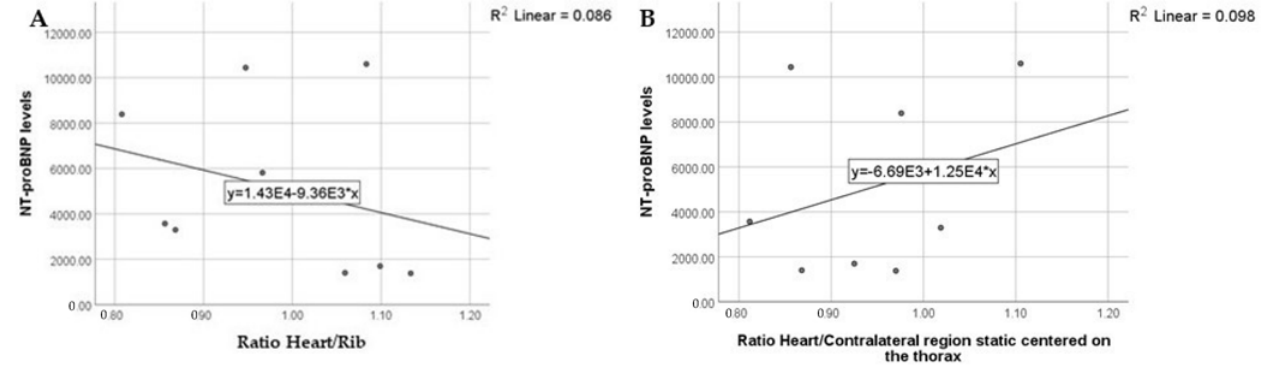
Figure 3. NT-proBNP levels in relation to the Heart/Rib ( A ) and Heart/Contralateral region (static centered-on-the-thorax images) ( B ) ratio results.